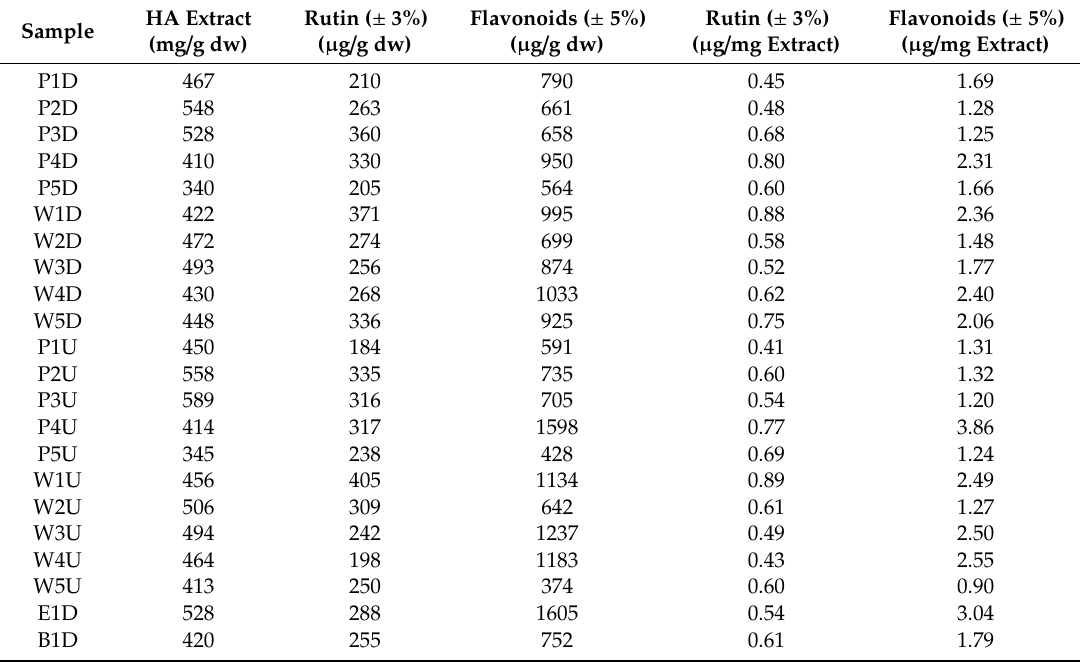
Table 2. Rutin and flavonoid content of analyzed goji berries hydroalcoholic (HA) extracts. Flavonoids are expressed as rutin equivalent using the HPLC areas collected at 360